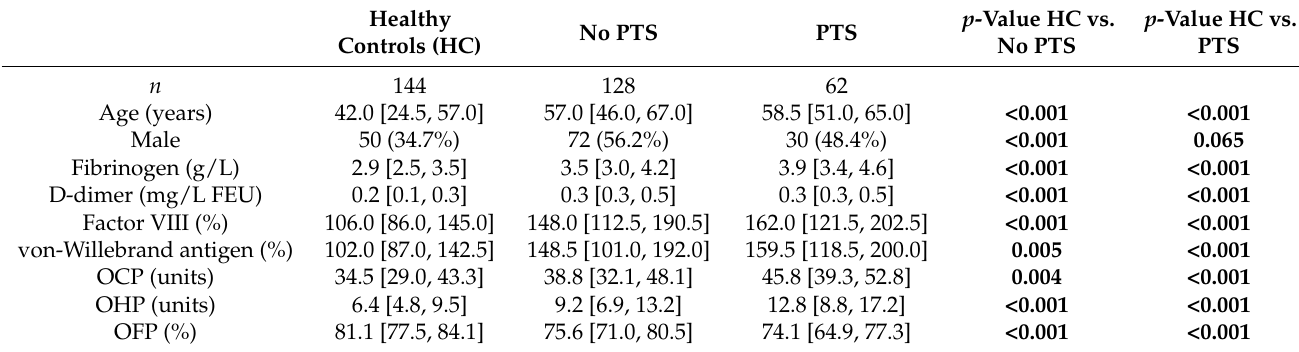
Table 2. OHP results and baseline characteristics for healthy controls and DVT patients, according to PTS status. Data are n (%), and median [interquartile range, IQR] unless specified otherwise.